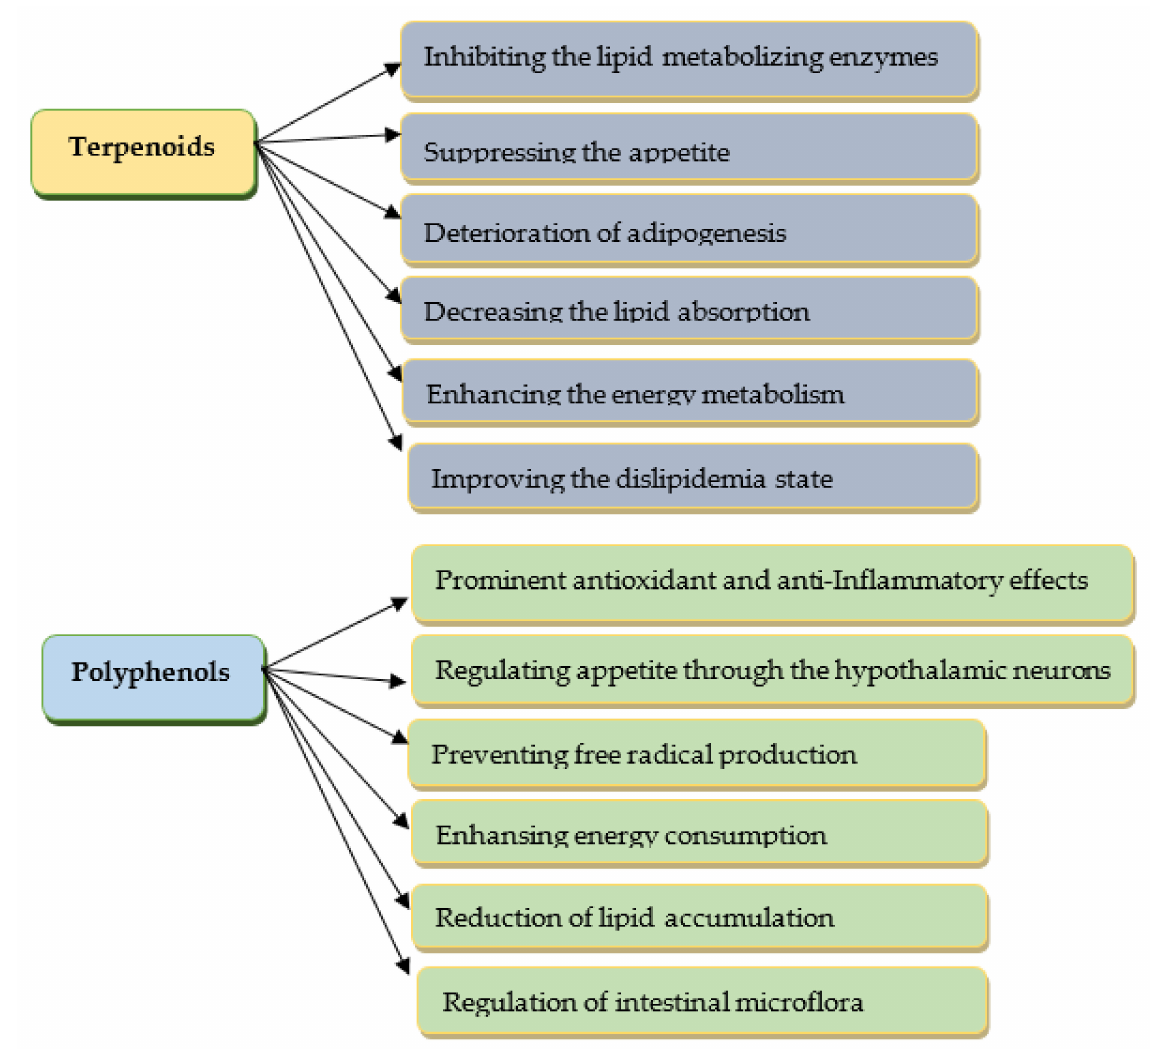
Figure 3. The anti-obesity effects of selected